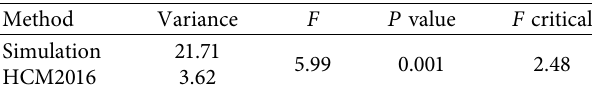
Table 3: F -test performed between simulation and HCM2016. Method Variance F P value F critical Simulation 21.71 5.99